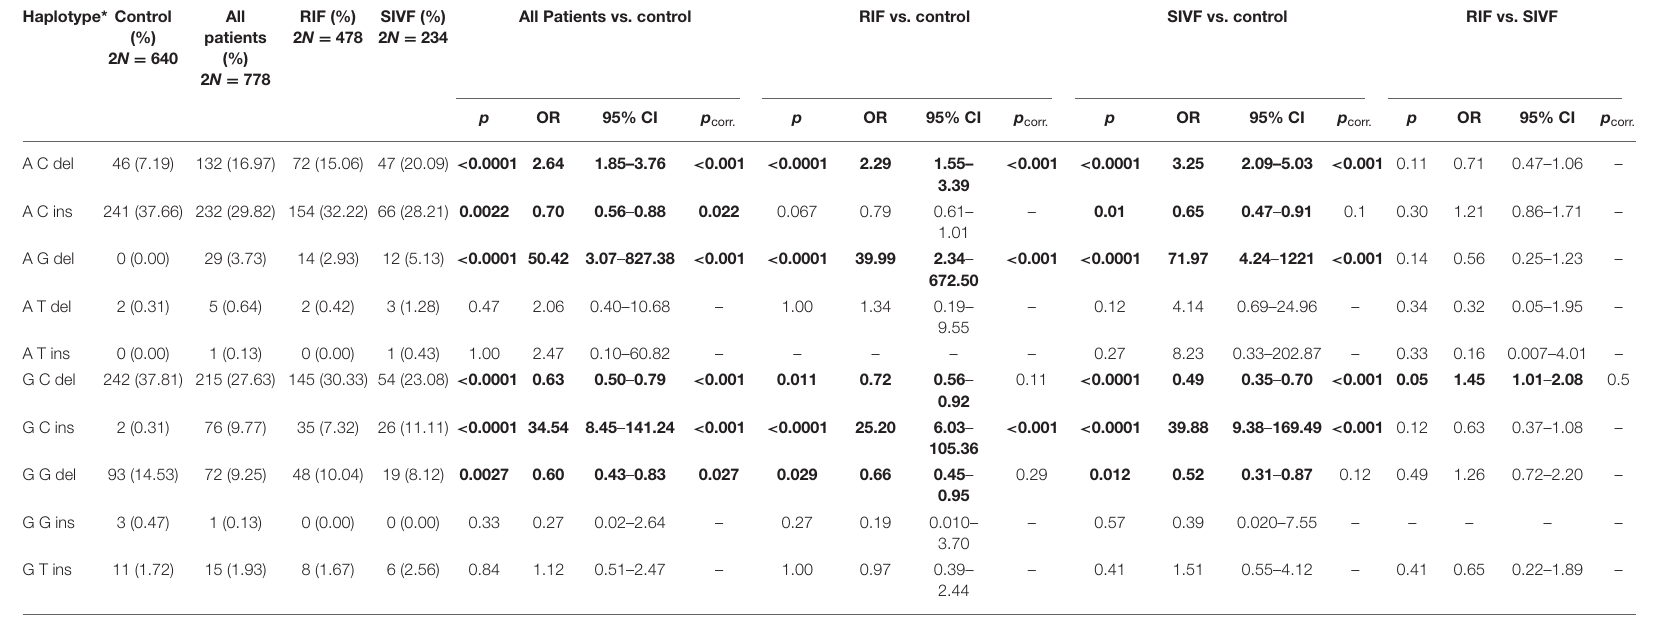
TABLE 3 | HLA-G haplotype frequencies in women from control and patient